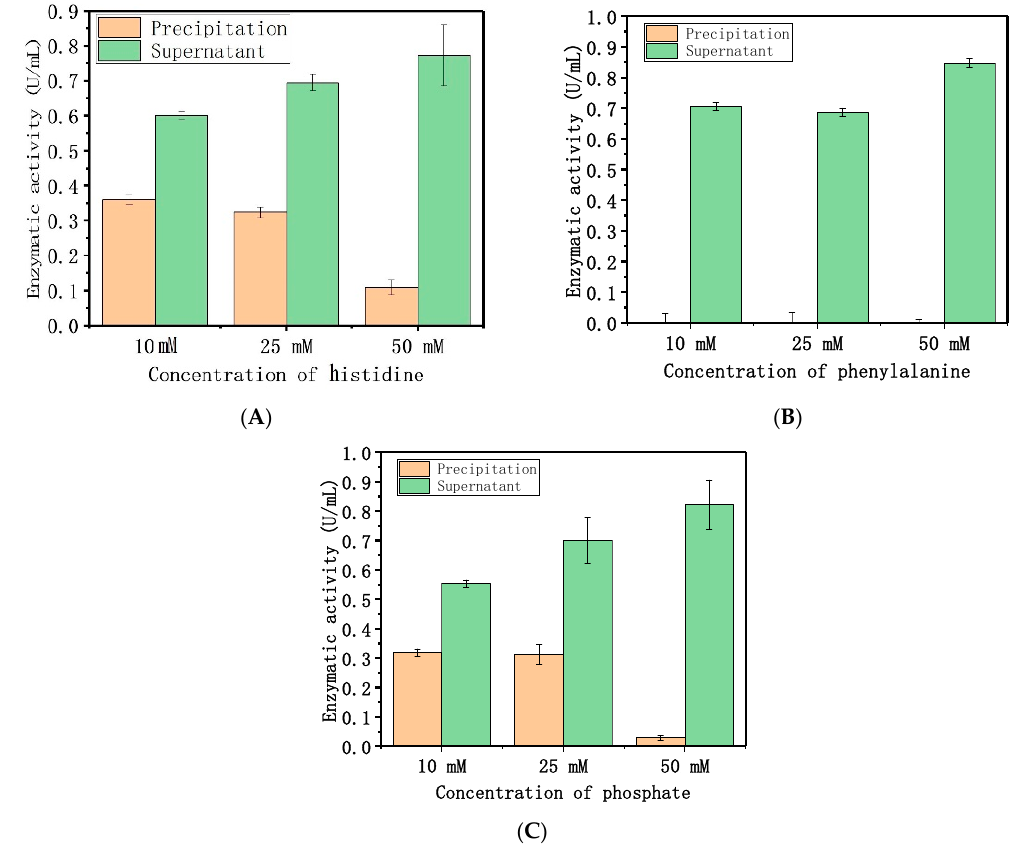
Figure 5. Effect of different concentrations of amino acids and phosphate on the elution of dextranase: ( A ) histidine, ( B ) phenylalanine, ( C ) phosphate.